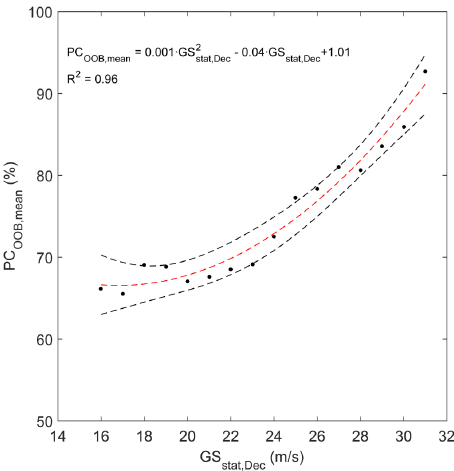
Figure 11. Out-of-bag samples of averaged probability class of modeled classified storm damage probability ( PC OOB,mean ) as a function of statistical gust speed of December for a return period of five years ( GS stat,Dec ).